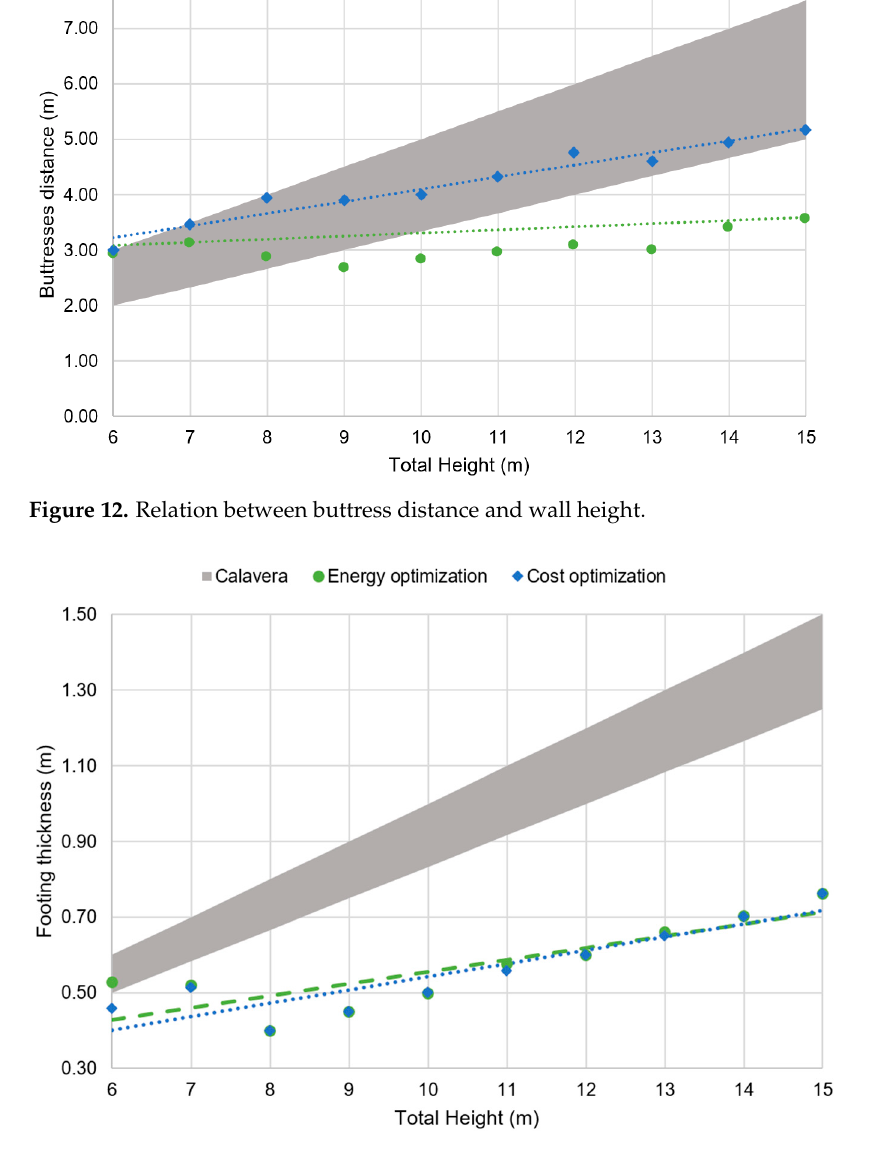
Figure 13. Relation between footing thickness and wall height.